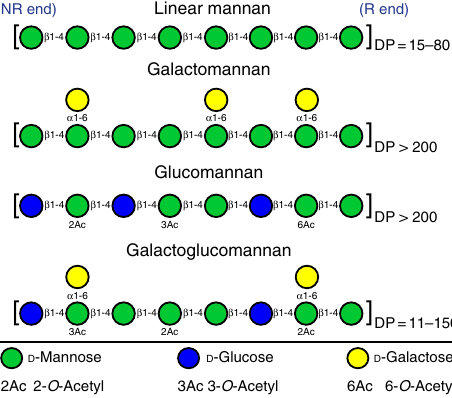
Fig. 1 General structure of the main classes of β -mannan. Linear homopolymeric (upper structure) and linear heteropolymeric (lower three structures) β -mannans are shown. Monosaccharides (D-mannose, green circle; D-glucose, blue circle; D-galactose, yellow circle) and acetylations (2Ac, 2- O -Acetyl; 3Ac, 3- O -Acetyl; 6Ac, 6- O -Acetyl) are represented using the standard Consortium of Functional Glycomics symbols 67 . NR end, non- reducing end; R end, reducing end; DP, degree of polymerization NATURE COMMUNICATIONS| (2019) 10:905